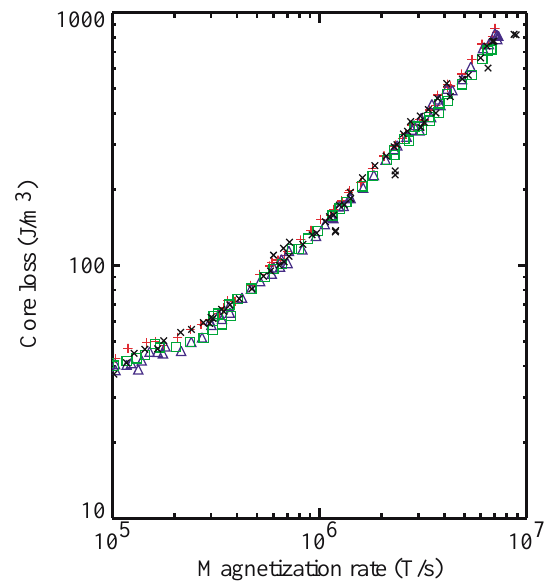
FIG. 18. (Color) Core loss versus magnetization rate for two FINEMET FT-1H nanocrystalline cores, manufactured by Hi- tachi. The data are for the listed flux swings: ( (cid:3) , blue) 982-4 at 2.10 T and ( 1 , red) 982-1 at 2.10 T. Not all pulses with core 982-4 reached 2.10 T; these were removed from the data